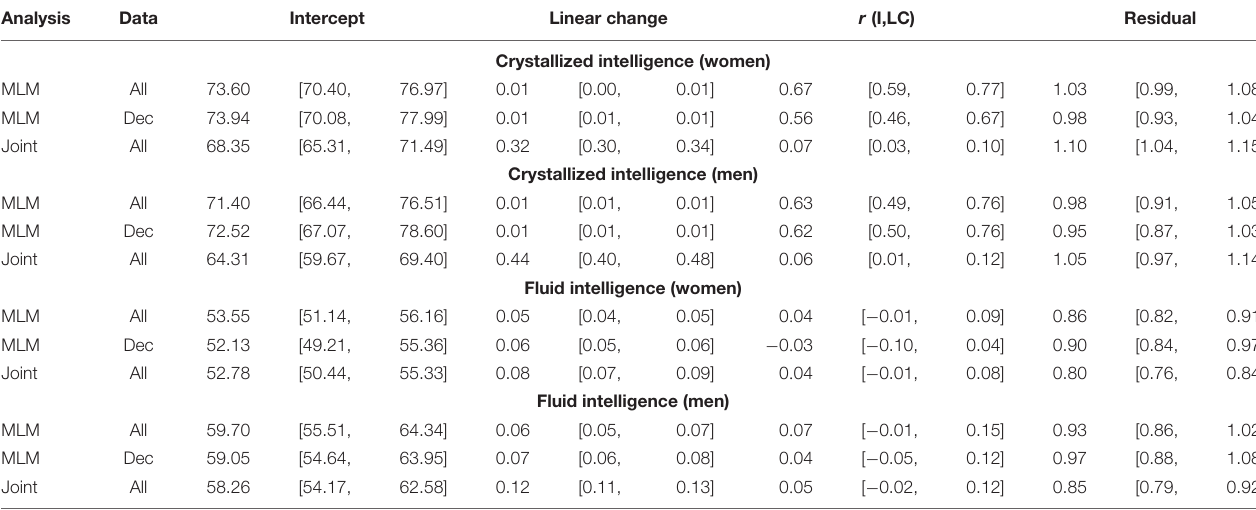
TABLE 6 | Random effects from quadratic change models (adjusted for starting age, self-rated health, and smoking). Analysis Data Intercept Linear change